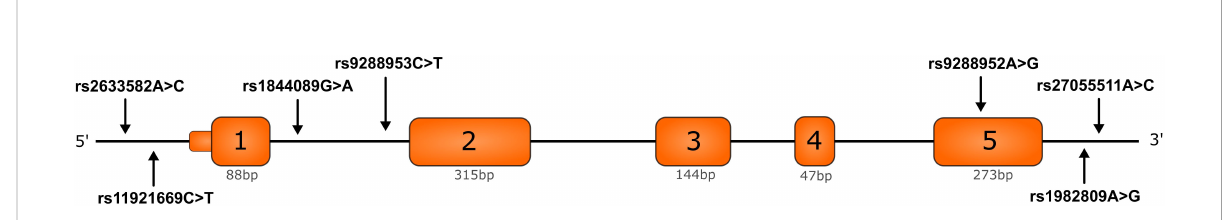
FIGURE 1 Structure of BTLA gene and localization of studied BTLA single nucleotide polymorphisms. Orange boxes indicate exons and black lines introns, 5 ’ UTR and 3 ’ UTR